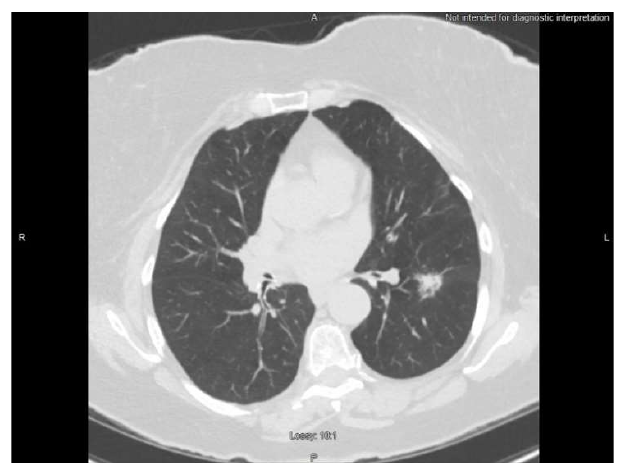
Figure 5. CT showing left lung lesion prior to